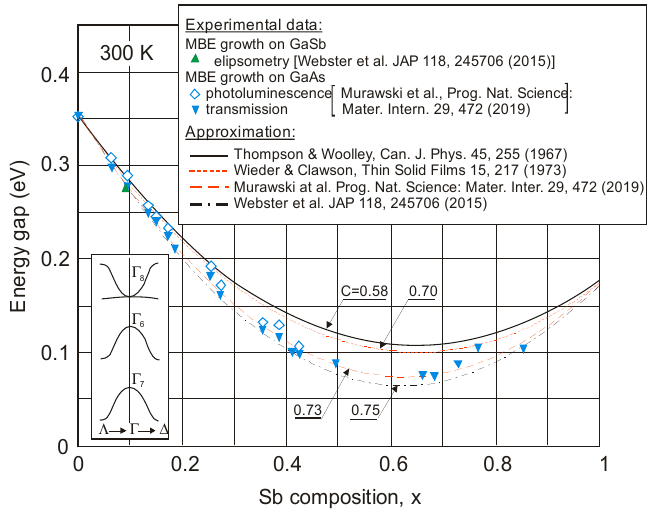
Figure4. InAs 1 − x Sb x bandgapenergyversustheSbcompositionatroomtemperature. Theexperimental Figure 4. InAs 1–x Sb x bandgap energy versus the Sb composition at room temperature. The data is taken with di ff erent papers [46–49] as indicated in the experimental data is taken with different papers [46–49] as indicated in the legend.